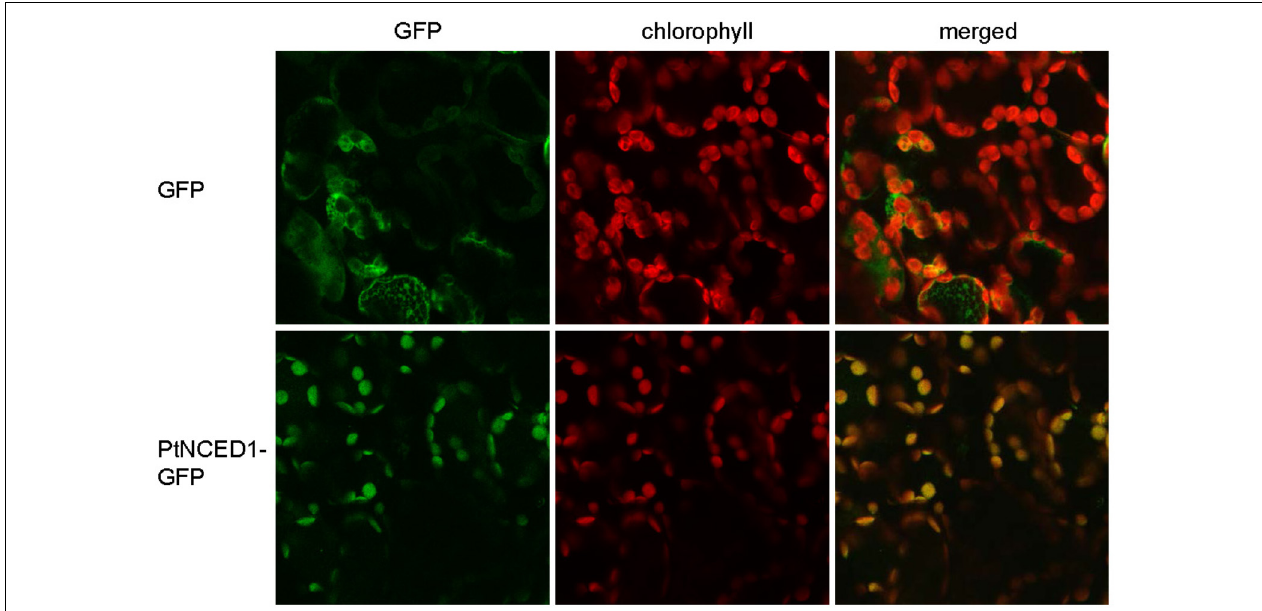
FIGURE 4 | Subcellular localization of PtNCED1 in chloroplasts. Nicotiana benthamiana leaves were agroinfiltrated to express the GFP protein or the PtNCED1-GFP fusion protein for 3 days. The signal for GFP is shown in green, the autofluorescence of chlorophyll is red, and the co-localized signal is yellow.